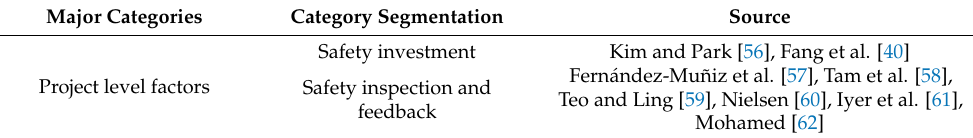
Table 4. Project level factors.